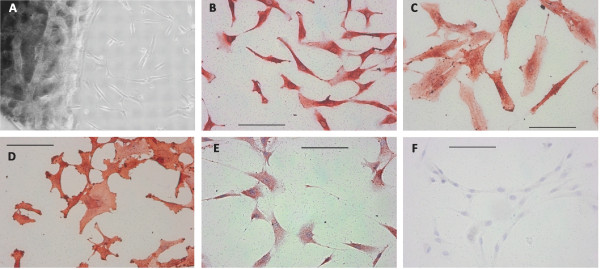
Freshly outgrown CPC were characterized morphologically and by immunocytochemical stainings. A: Cartilage slice after 11 days of cultivation with emigrated cells of fibroblastoid appearence. B-F: Immunocytochemical staining of chondrogenic progenitor cells (CPC) specific for CD73 (B), CD90 (C), CD166 (D) and CD54 (E); F: negative control. The bar indicates 100 μm.